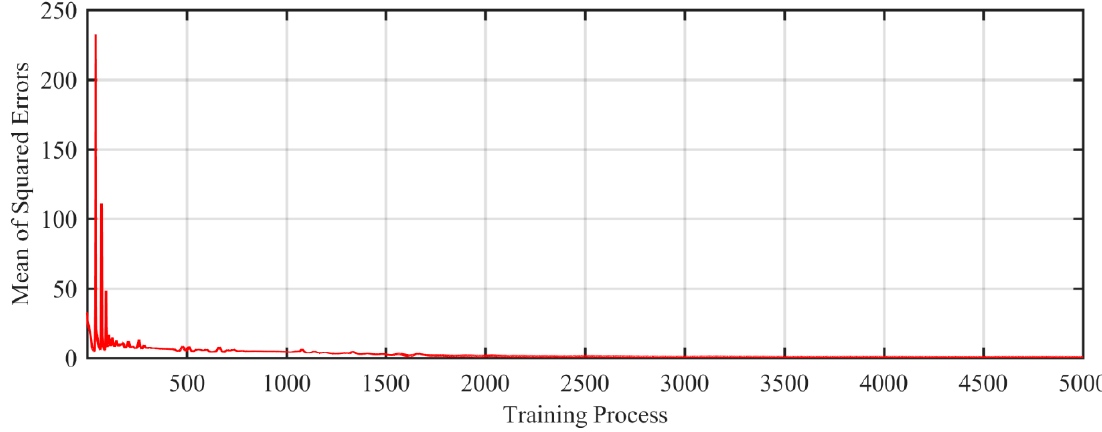
Figure 10. Variation of the squared error sum during training.